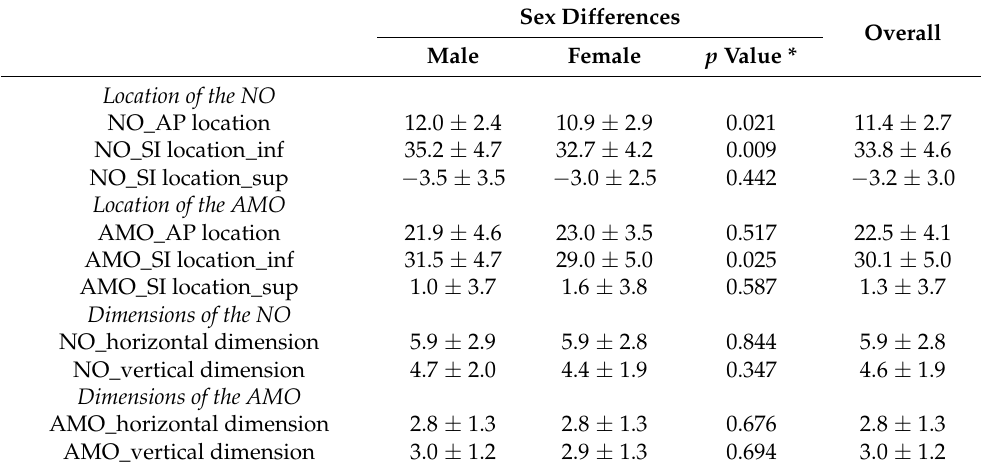
Table 4. Location and dimension of the natural ostium and accessory maxillary ostium.